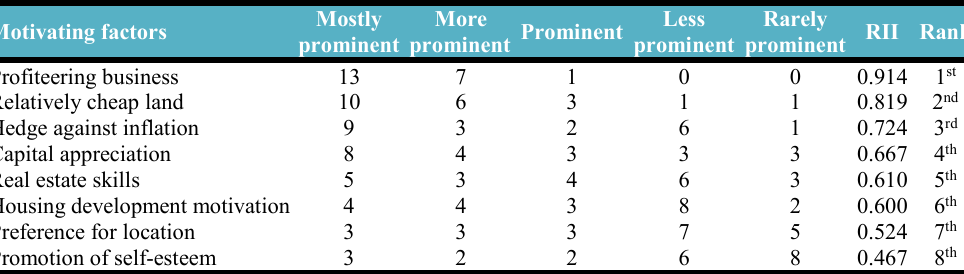
Table 6. Motivating Factors for Investing in Land Speculation